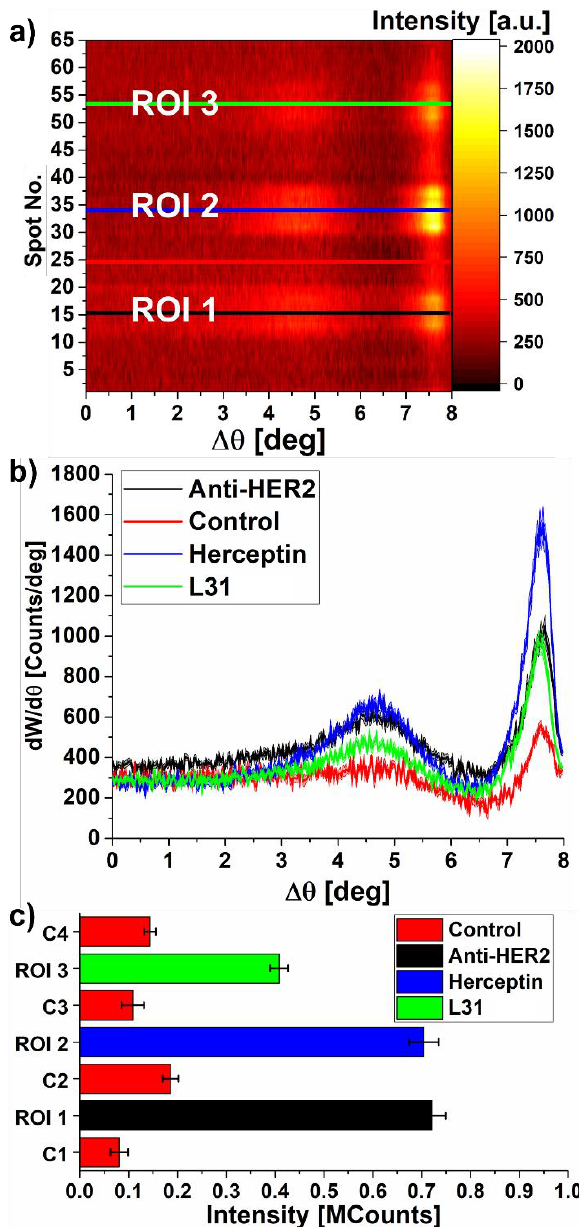
Fig. 3 – In the fluorescence spectral map (a) recorded over the investigated area the three brighter regions correspond to the three ROIs. (b) shows the Fluorescence angular spectra extracted from map (a): black, blue and green spectra correspond to ROI No. 1,2 and 3 respectively, while the red spectrum is extracted from a point of control region No. 2 (listed as